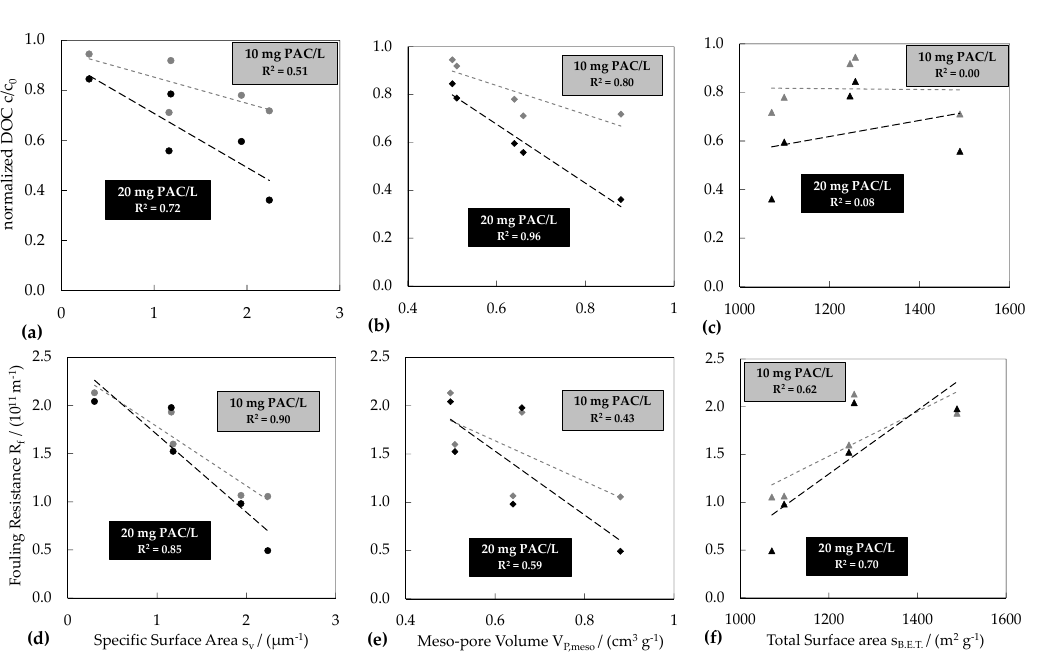
Figure 8. Normalized average DOC concentration (top) and average fouling resistance (bottom) versus ( a , d ) specific surface area; ( b , e ) meso-pore volume; ( c , f ) total surface area (B.E.T.) of all tested PACs with linear correlations.